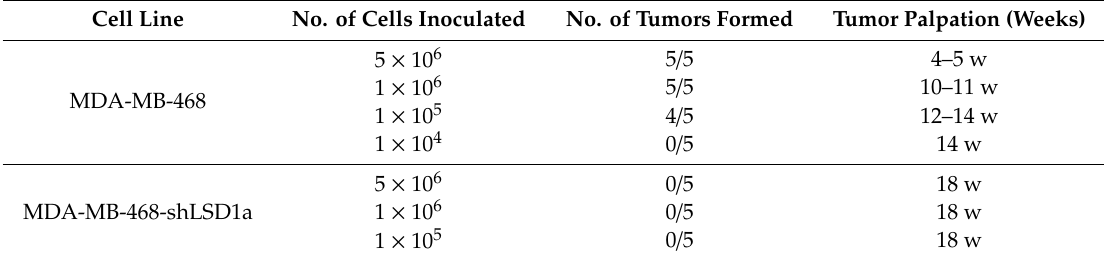
Table 1. Limiting dilution assays with parental and LSD1 knock-down MDA-MB-468 breast cancer cells in